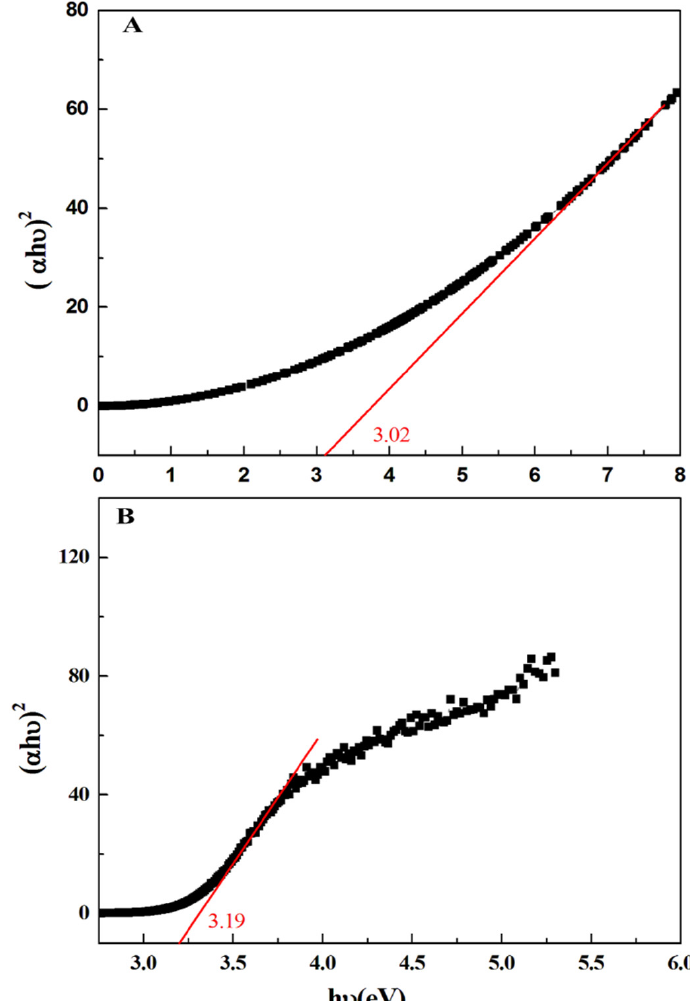
Figure 8. Spectrum of photon energy ( α h ν ) 2 as a function of the h ν photon of TiO 2 nanoparticles ( A ) for TiO 2 NPs at 1 h, and ( B ) for TiO 2 NPs at 5 h.